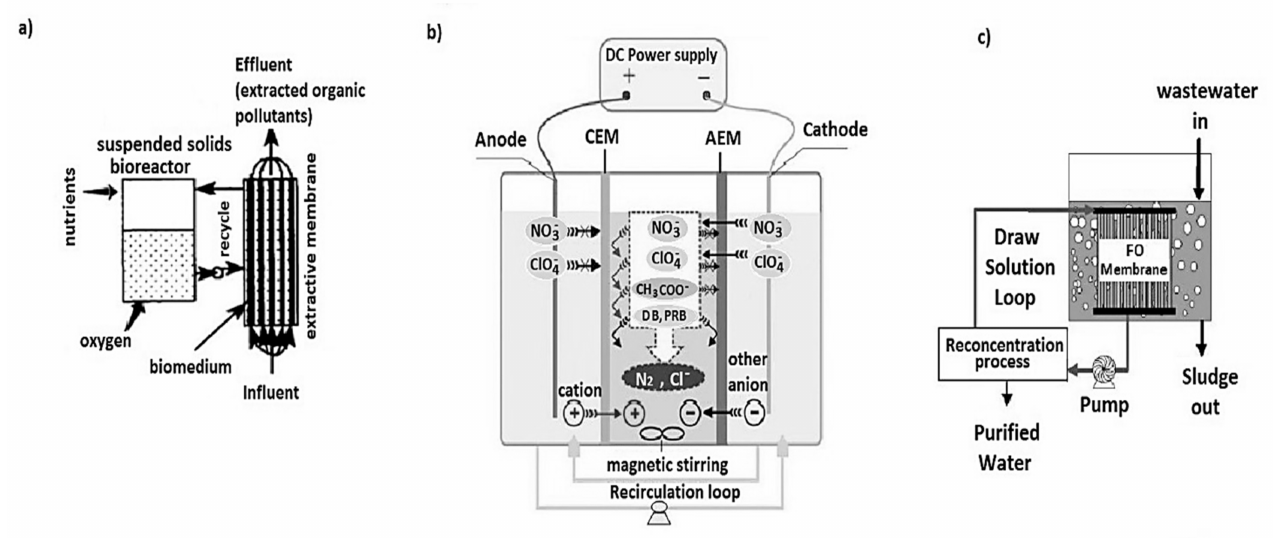
Figure 4. ( a ) Extractive membrane reactor; ( b ) Electro-dialysis ion exchange membrane bioreactor; ( c ) Osmotic bioreactor adapted from